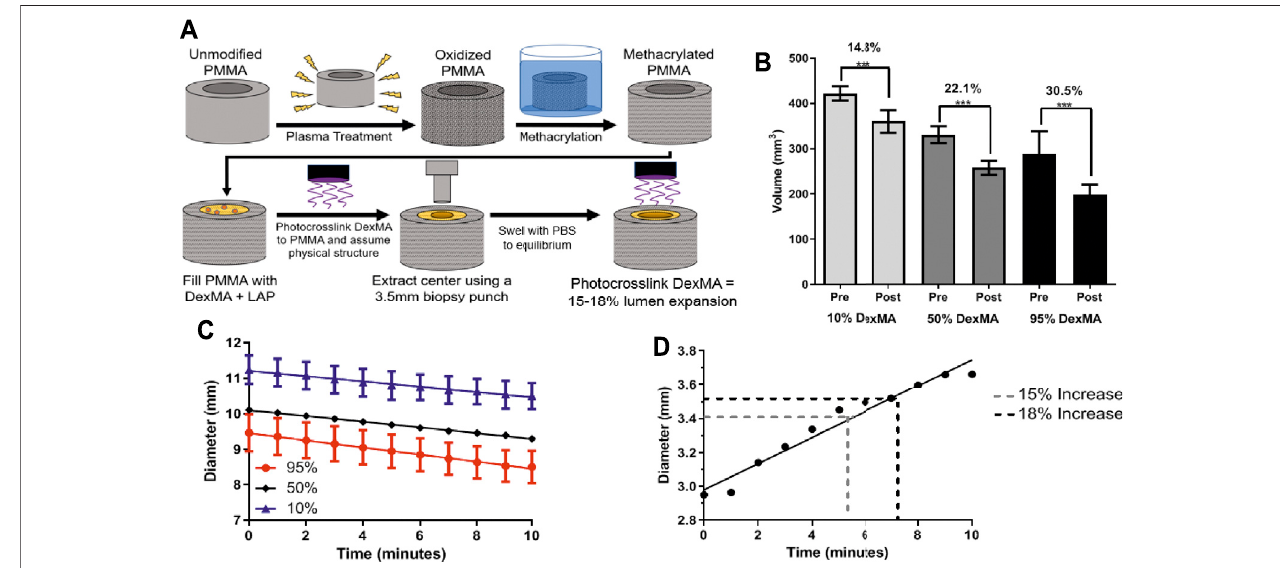
FIGURE6|(A) AschematicofthePMMAtubingfunctionalizationprocessandDexMAprototypefabricationofarigidPMMAouterlayer fi lledwithDexMAhydrogel with3.5 mm circularpunch extracted fromthe center. (B) Volumecomparison before (Pre)and after (Post) 10 min ofnear-UV crosslinking ofDexMA gels ( n (cid:1) 3; mean ± s.d.; *** p < 0.001). 95% DexMA demonstrated largest volume change (C) Diameter change upon UV-crosslinking of DexMA gels based on image capture analysis in MATLAB (D) Temporaldependenceofdiameterchangeuponnear-UVcrosslinkingofDexMAgelsbasedonimagecaptureanalysisinMATLAB(mean ±